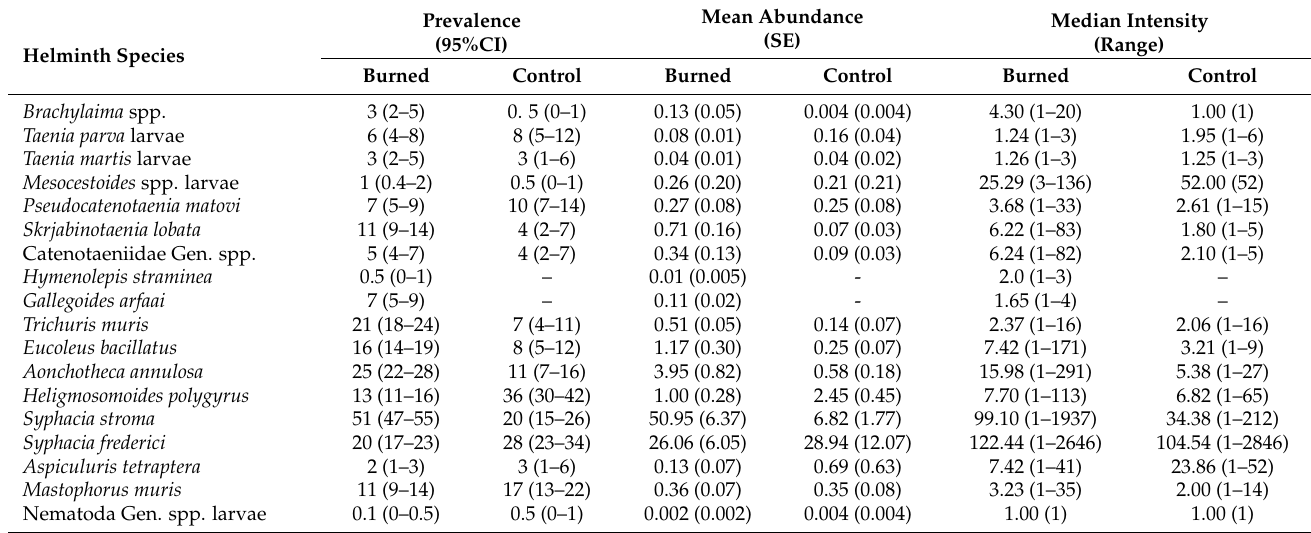
Table 5. Characterization of the helminth community of the wood mouse in the burned ( n = 675) and control ( n = 242) areas. CI, confidence interval; SE, standard error. FES, helminths which have a free-environmental infectious stage for the wood mouse.